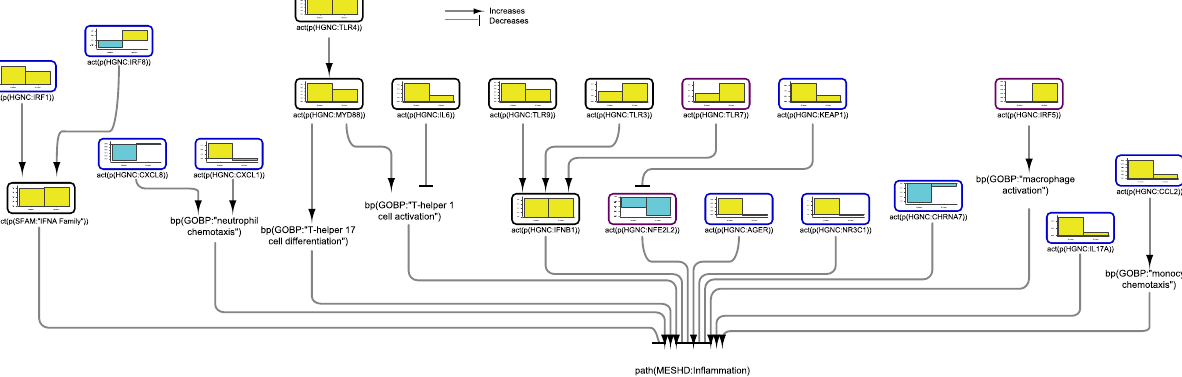
Figure 4. Impact of IBD on signalling pathways leading to inflammation in colonic mucosa. The subgraph extracted from the merged IBD network model shows the iNode enrichment score for each node when scored with comparative transcriptomic data from IBD-affected versus healthy control samples. The values are not comparable between the graphs, and the scale is adjusted on the basis of the highest value for each node. Most intermediate nodes that were not scored have been removed for simplicity (The complete results are in Supplementary file 1). Black outlines indicate nodes that were significantly impacted in both CD and UC samples; blue outlines indicate nodes that were significantly impacted in CD samples; and purple outlines indicate nodes that were significantly impacted only in UC samples. The directionalities are shown as yellow or turquoise bars for inferred upregulation or downregulation, respectively. The order is as follows: 1) CD and 2) UC. Abbreviations: act, protein activity; p, protein abundance; bp, biological process. HGNC is the namespace for human proteins; GOBP is the namespace for biological processes; MESHD is the namespace for diseases; and GOCC is the namespace for complexes. SFAM and PMIBP are custom namespaces for protein families and biological processes, respectively. The figure was created using Cytoscape v3.7.1 (https:// cytos cape. org). The Cytoscape graph was then exported to pdf and the layout was further modified for better readability in Adobe Illustrator 2019 (https:// adobe. com).